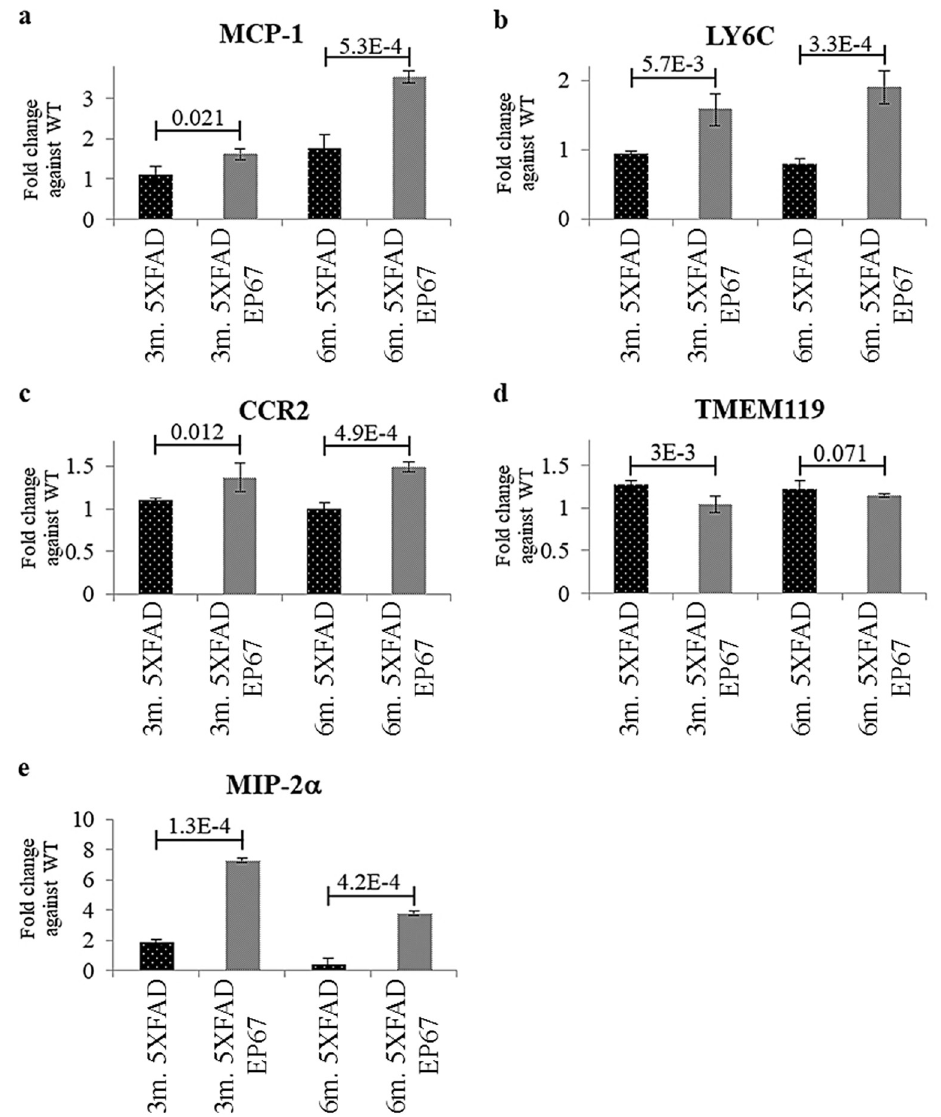
Fig 12. Phagocytes gene expression levels in the brain. The levels of gene transcripts were measured through RT-QPCR. (a) MCP-1 a monocyte chemoattractant was found to be significantly increased in animals receiving the EP67 treatment, MIP- 2a (b) the leukocyte chemoattractant appears to be massively overexpressed following treatment with EP67. The expression of the microglia specific marker TMEM119 (c) remains unchanged amongst all groups. CCR2 (d) and LY6C (e), both found to be expressed in monocytes also appear to be significantly increased in animals receiving the EP67 treatment. Comparative CT Method ( ΔΔ Ct) against relevant wild type samples, n =